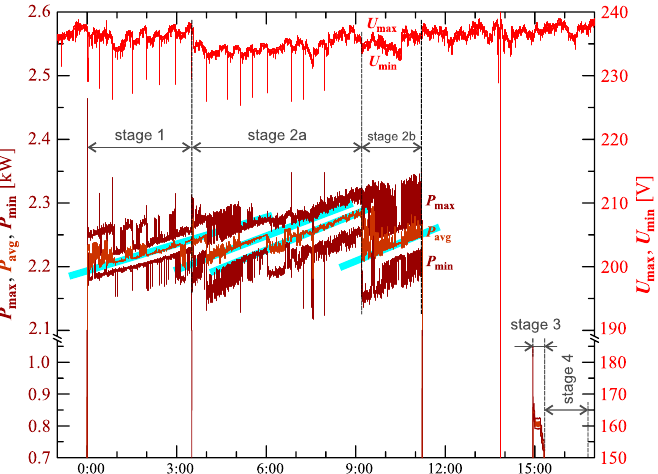
Figure 24. The characteristics of maximum P max = f ( t ) and minimum P min = f ( t ) values of active power and average values of reactive power Q agv = f ( t ) for Case III.